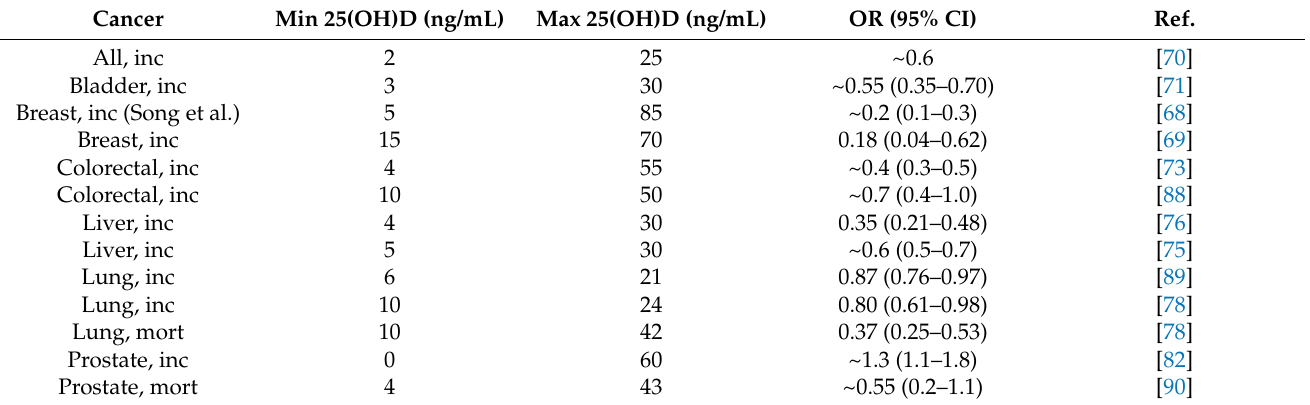
Table 7. Estimates of odds ratio for maximum 25(OH)D concentration compared with minimum concentration for several